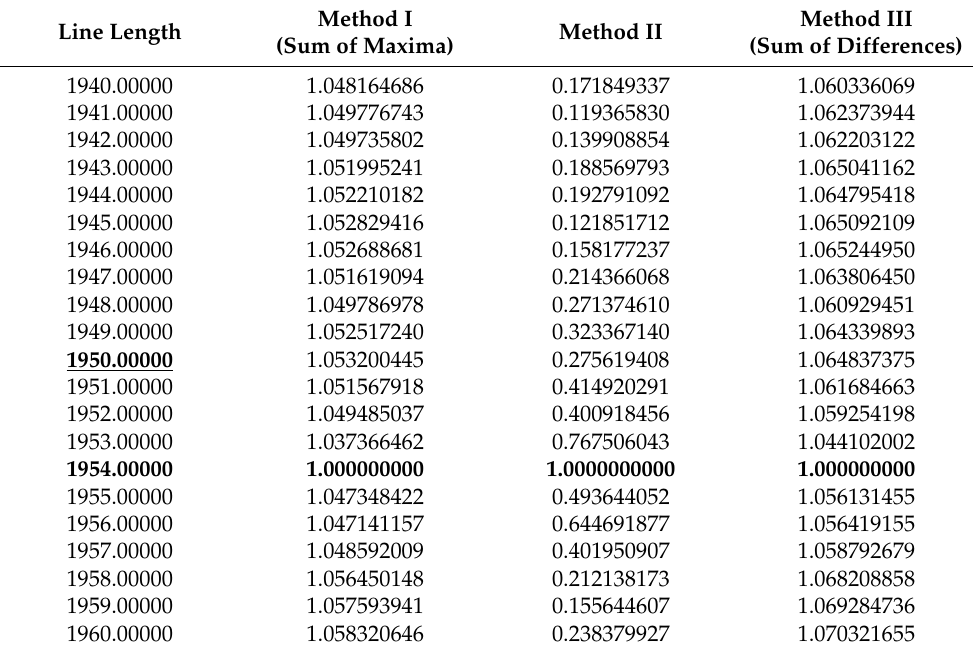
Table 3. Image line length estimation results for the accuracy ∆ = 1.0.